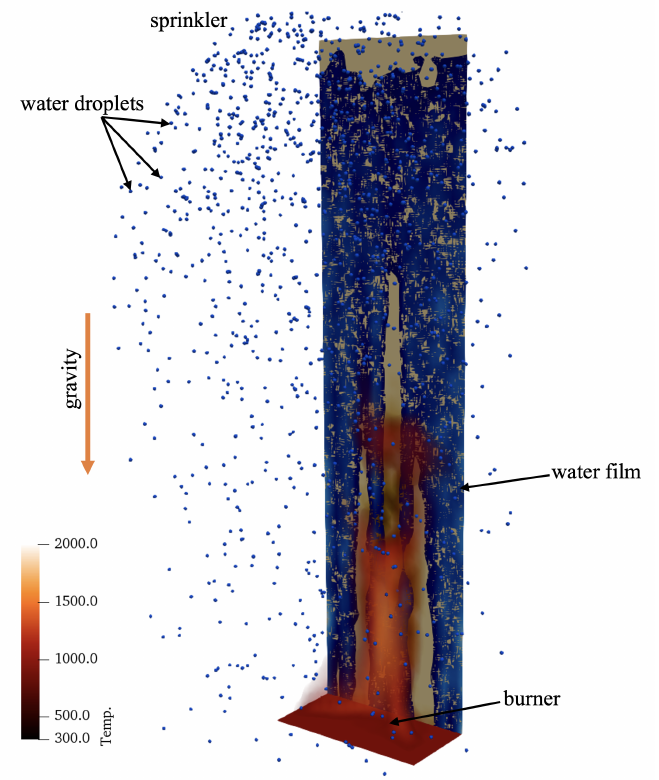
Figure 10. Visualization of baseline sprinkler case, showing gas, liquid, and solid phases. Gas-phase combustion is visualized by a volume-render of cells with high temperature colored from low (black) to high (red) and solid-phase pyrolysis is visualized by char production colored low (tan) to high (black). Water is shown in blue for particle- and film-based